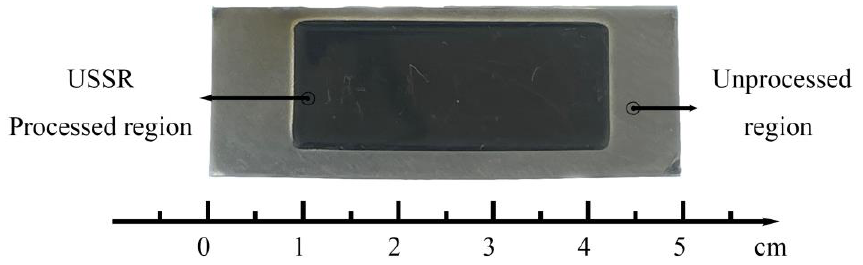
Figure 1. Appearance of the sample after USSR processing.